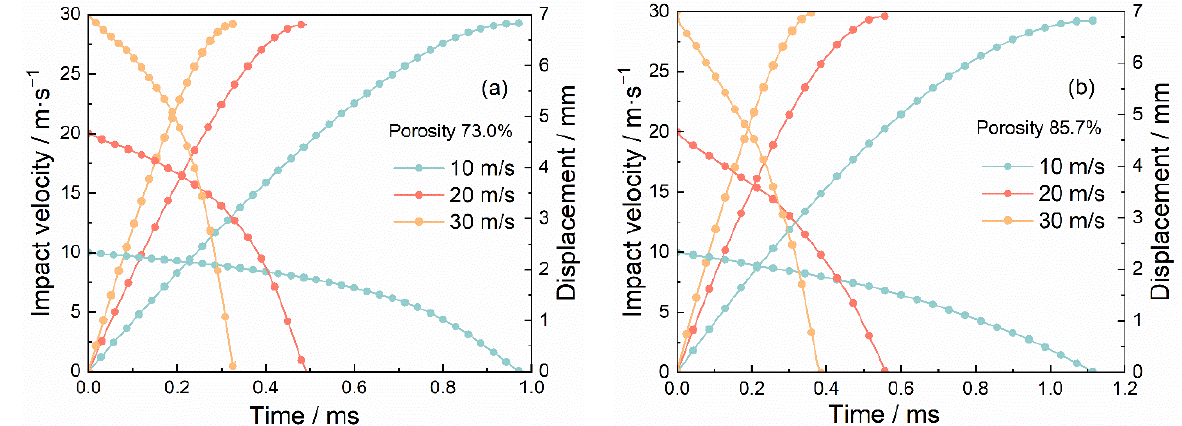
Figure 16. Impact velocity and displacement duration of specimens with ( a ) 73.0% porosity and ( b ) 85.7% porosity at various impact velocities.